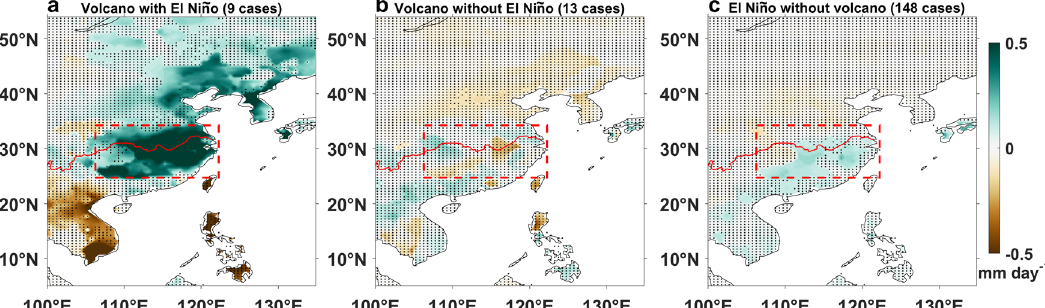
Fig. 2 Role of El Niño in post-eruption EASM change based on reconstructions. Superposed epoch analysis results of East Asian precipitation anomalies (shading) in the fi rst boreal summer after a 9 tropical eruptions with and b 13 eruptions without an El Niño in the fi rst winter after the eruption, and after c 148 non-volcanic El Niños during the period of 1470 – 1999 AD. An El Niño event is de fi ned by the average of the 11 reconstructions of the ENSO index (see “ Methods ” ). Stippling indicates precipitation anomalies not signi fi cant at the 90% con fi dence level. The red curve is the Yangtze River, and the red box indicates the EASM region. This fi gure was created using MATLAB 2020a